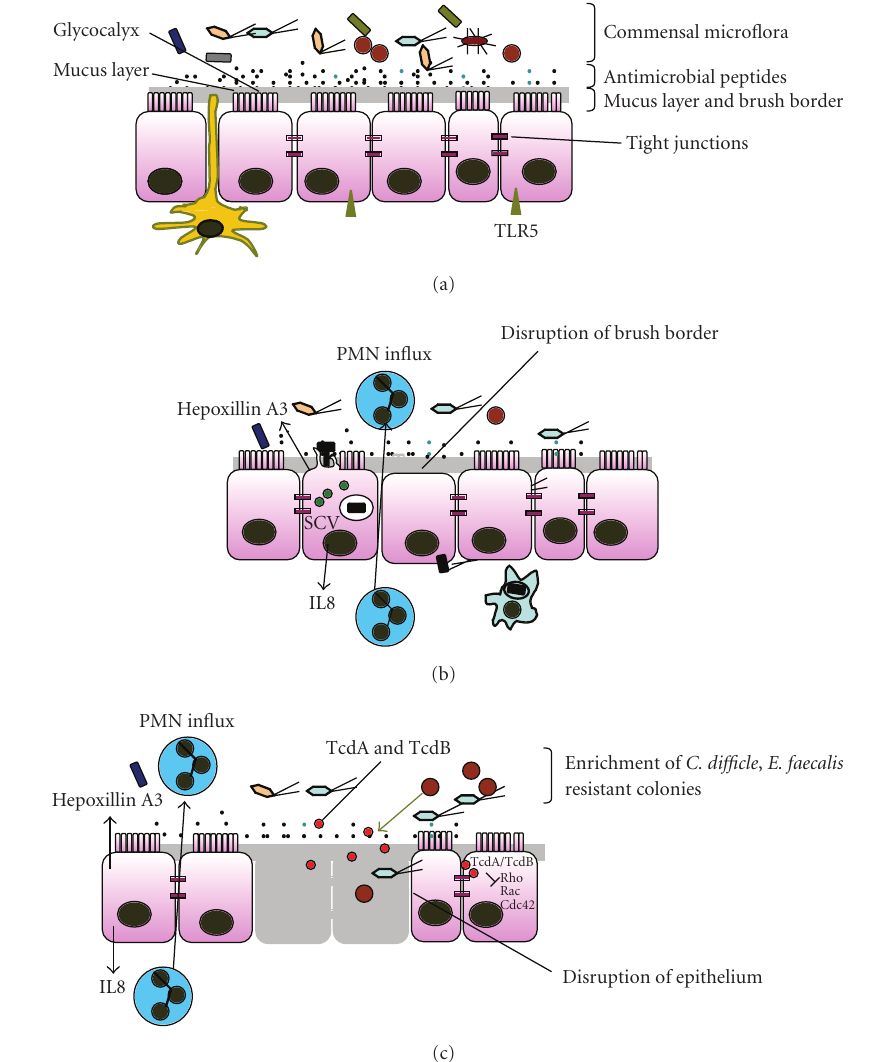
Figure 1: (a) Healthy epithelial surface. A healthy intestinal epithelial surface acts as a physical and biochemical barrier with key features including the apical brush border, the mucus layer, the presence of antimicrobial peptides (blue black dots) in the lumen, the glycocalyx, and the epithelial tight junctions. Also seen in the illustration are numerous commensal bacteria and a dendritic cell sampling the lumen with its extended dendrites (yellow). (b) Key features of S. typhimurium infected epithelium. Such host pathogen interactions involve translocation of bacterial e ff ectors (green circles) into the epithelial cells, membrane ru ffl ing, bacterial endocytosis, and SCV formation. Chemoatractants are secreted by the epithelial surface that leads to PMN influx. SCV: Salmonella containing vacuole. (c) Intestinal epithelial surface of an antibiotic-treated patient showing enrichment of a set of antibiotic resistant members of the commensal microflora (light blue and brown) such as C. di ffi cle and E. faecalis . The C. di ffi cle proteins, TcdA and Tcdb (red circles) act intracellularly as glycosyltransferases and inhibit Rho, Rac, and Cdc42. The e ff ect of these modifications lead to actin condensation, transcriptional activation of several genes and apoptosis. Other mechanisms that are triggered include basolateral IL8 secretion, apical Hepoxillin A synthesis, and PMN influx in the apical